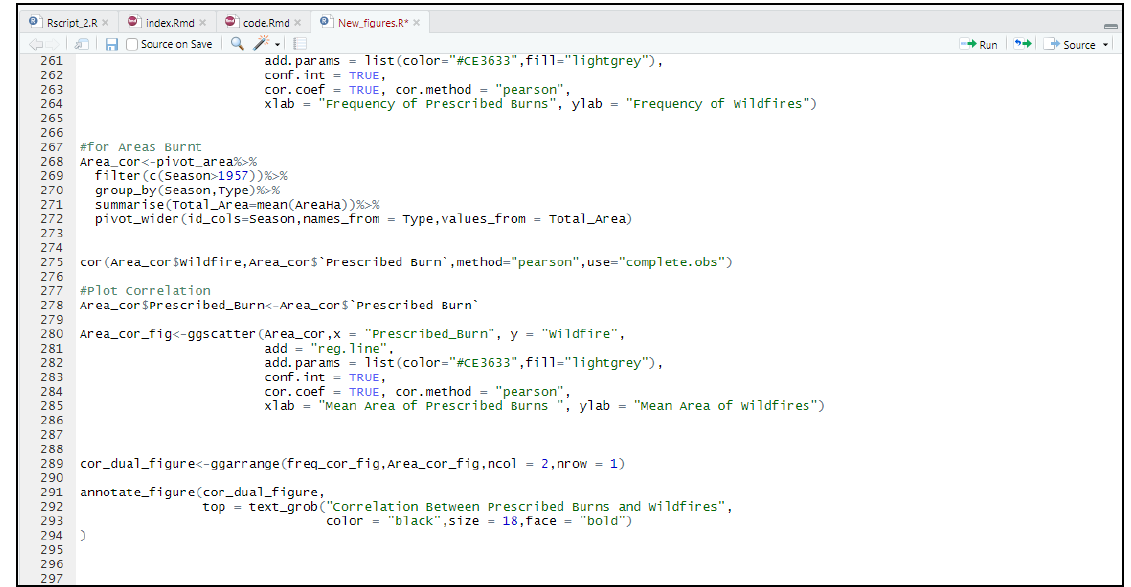
Figure 4. Snippet of R scripts for the correlation method.